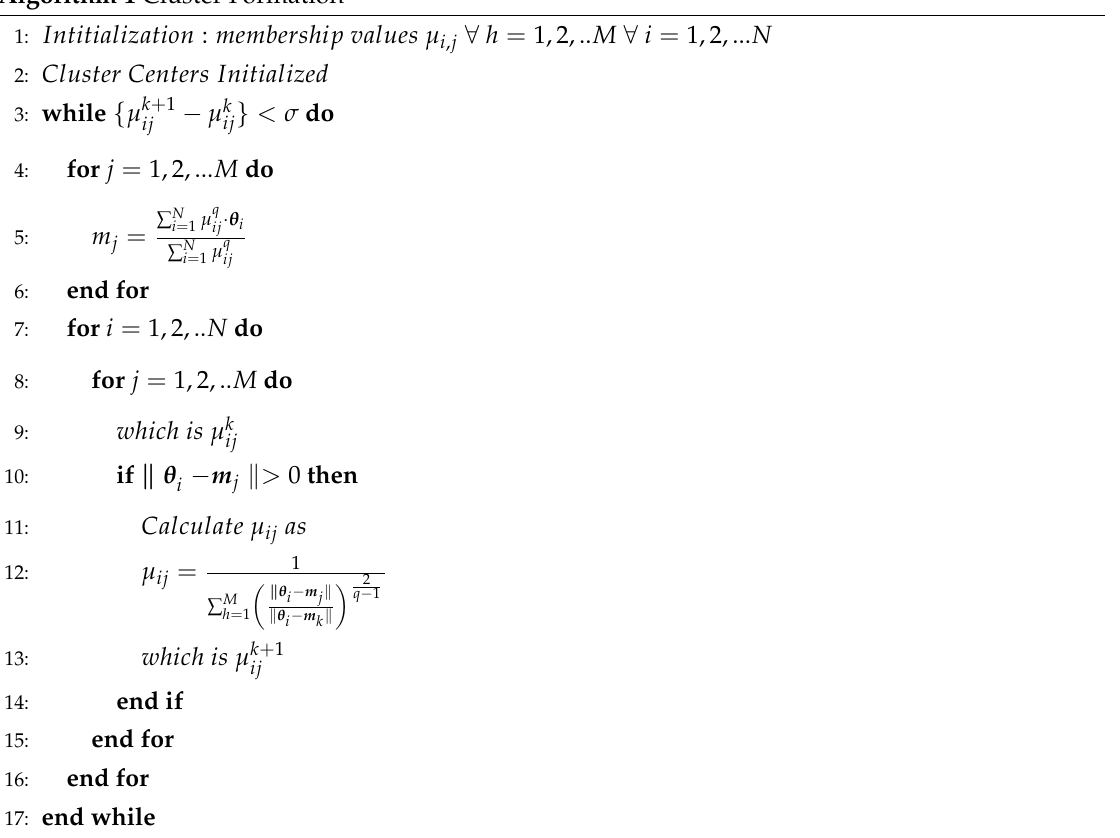
Algorithm 1 Cluster